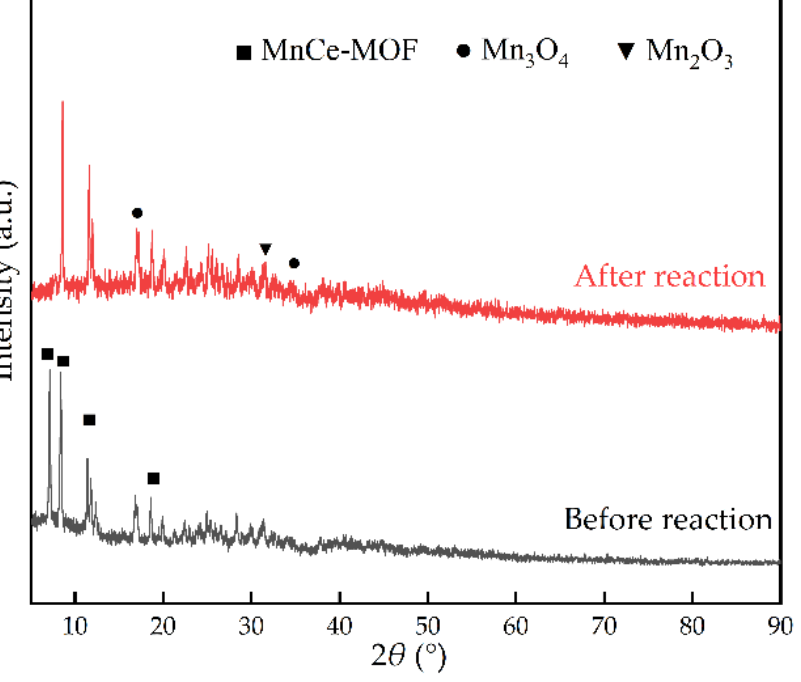
Figure 10. PXRD patterns of MCD6 before and after reaction.